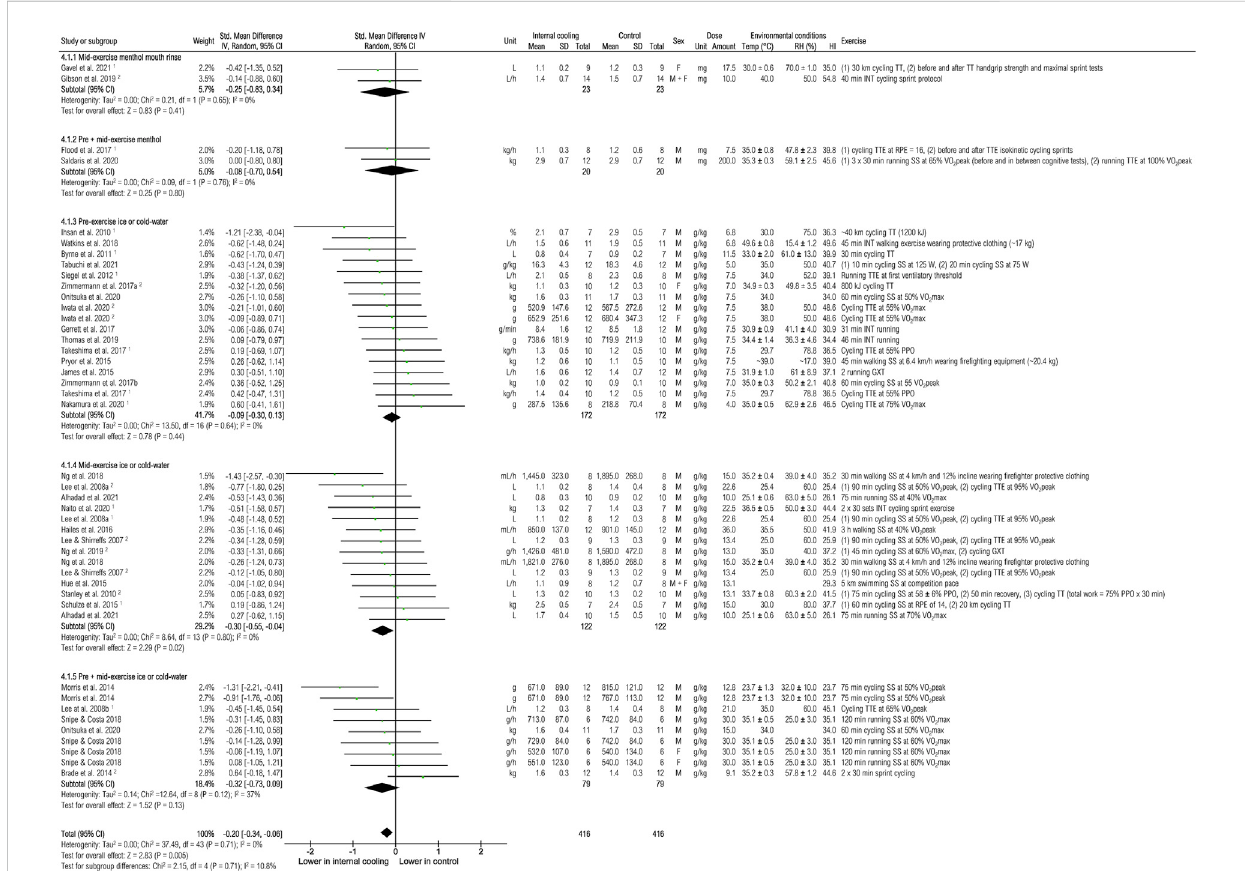
FIGURE 7 Meta-analysis of standardized mean difference in sweat rate with 95% CI between internal cooling and control. 1 Studies with signi fi cant positive performanceeffectsofinternalcooling. 2 Studieswithnoperformanceeffectsofinternalcooling.F,female;GXT,gradedexercisetest;HI,heatindex;INT, intermittentexercise;M,male;MVC,maximumvoluntarycontraction;PPO,peakpoweroutput;RH,relativehumidity;RPE,rateofperceivedexertion;SS, steady-state exercise; Temp, ambient temperature; TT, time trial; TTE, time to exhaustion; VO 2 max, maximum oxygen consumption; VO 2 peak = peak oxygen